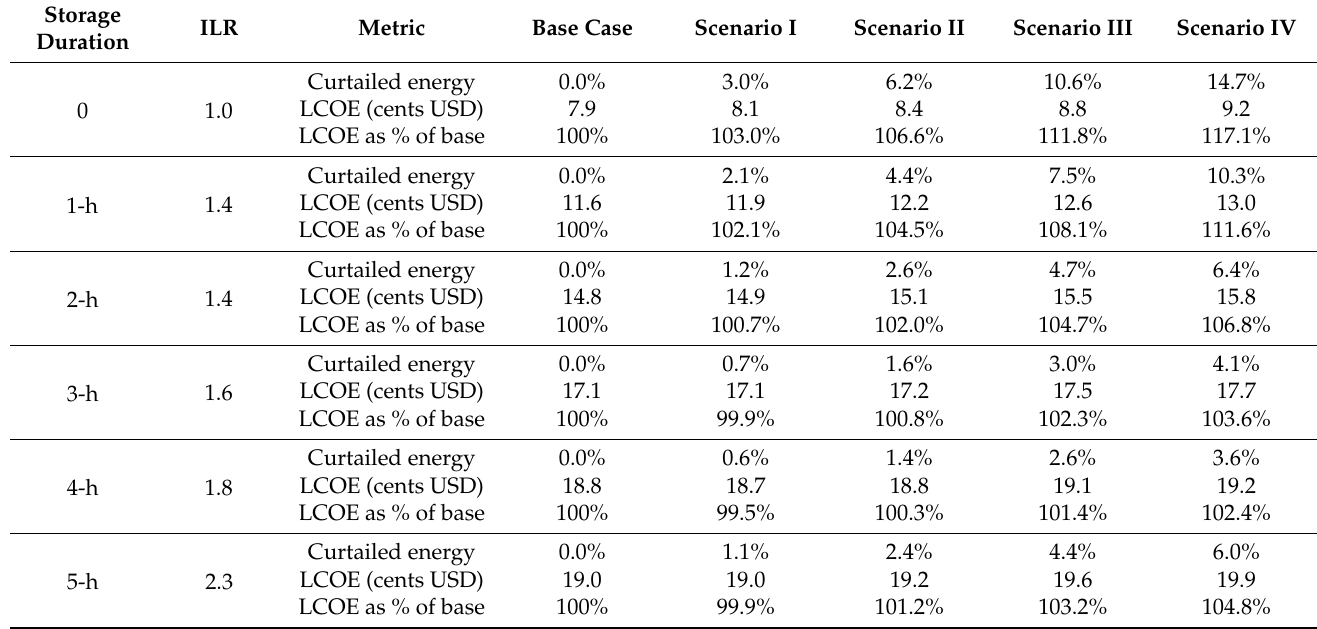
Table 8. Impact of curtailment on LCOE for fixed-tilt PV plus battery systems.